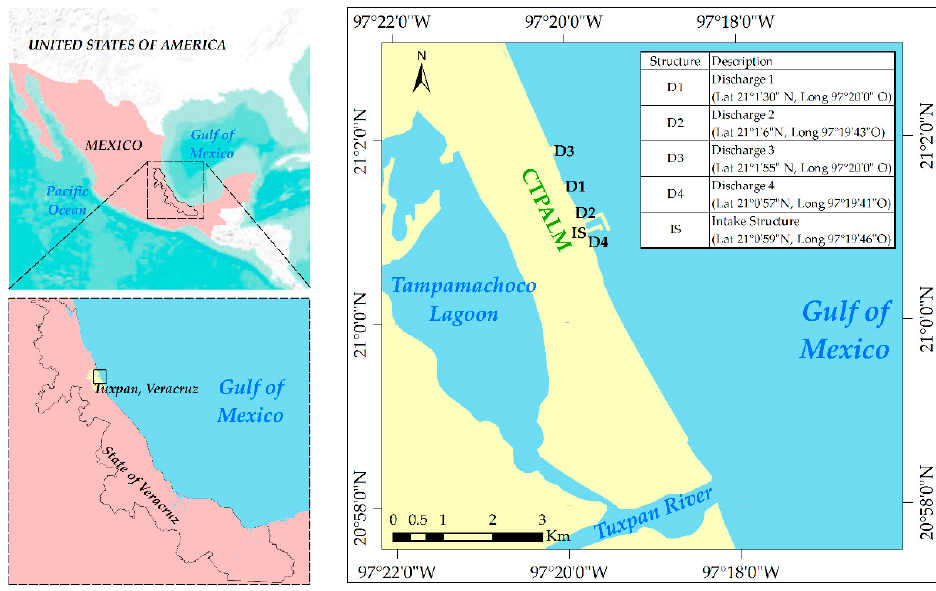
Figure 1. Location of the CTPALM power plant.